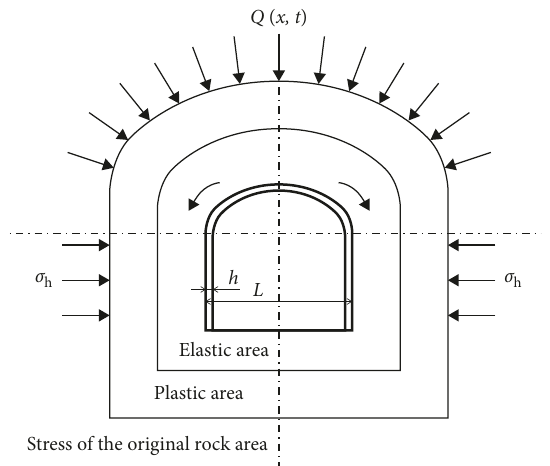
Figure 1: Coupling model of the roof of the surrounding rock and supporting body. Q ( x,t ) is the sum of the uniform load and vi- bration of the roof plate, acting on the upper part of the bar; σ the horizontal stress, acting on the horizontal direction of the bar; L is the length of the bar and can be the span of U-shaped steel; h is the thickness and can be set to unit length